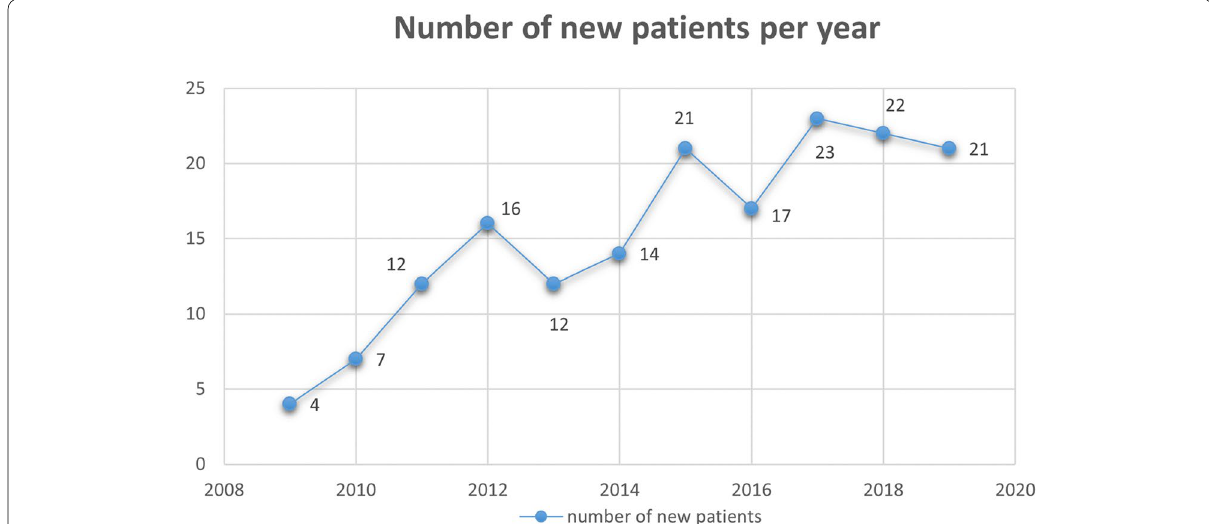
Fig. 1 The number of new patients per year